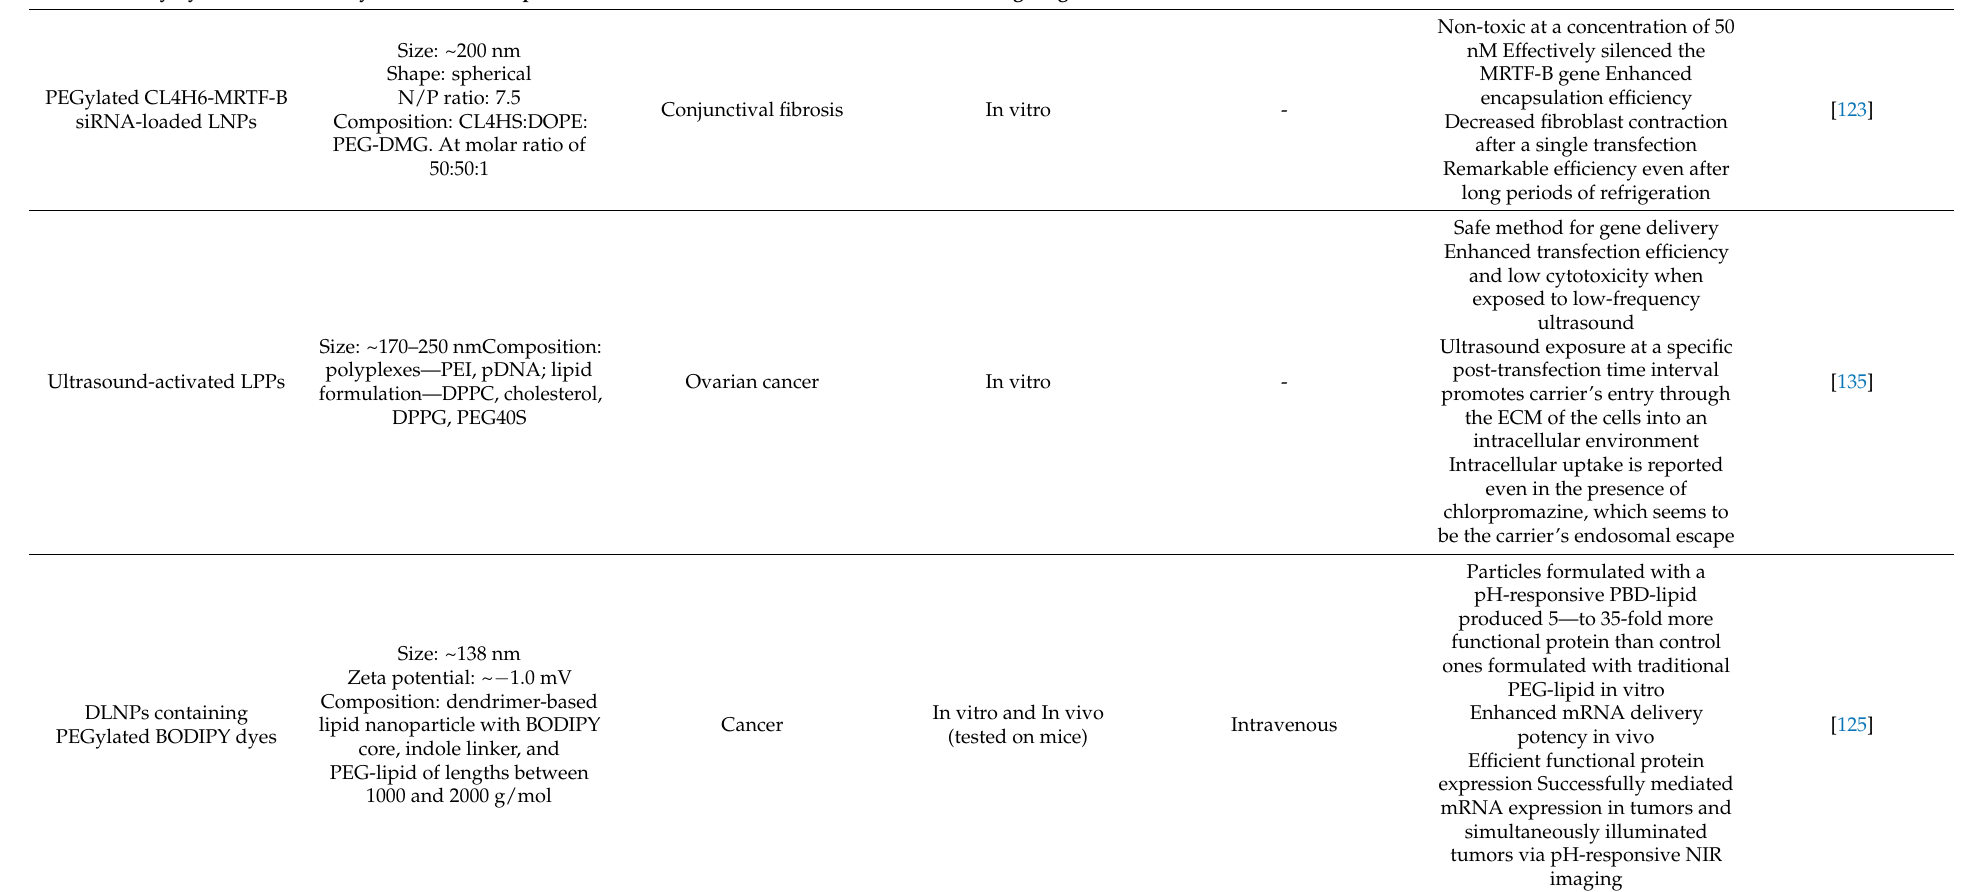
Table 3. A summary of lipid-polymer hybrid-based nucleic acids delivery systems